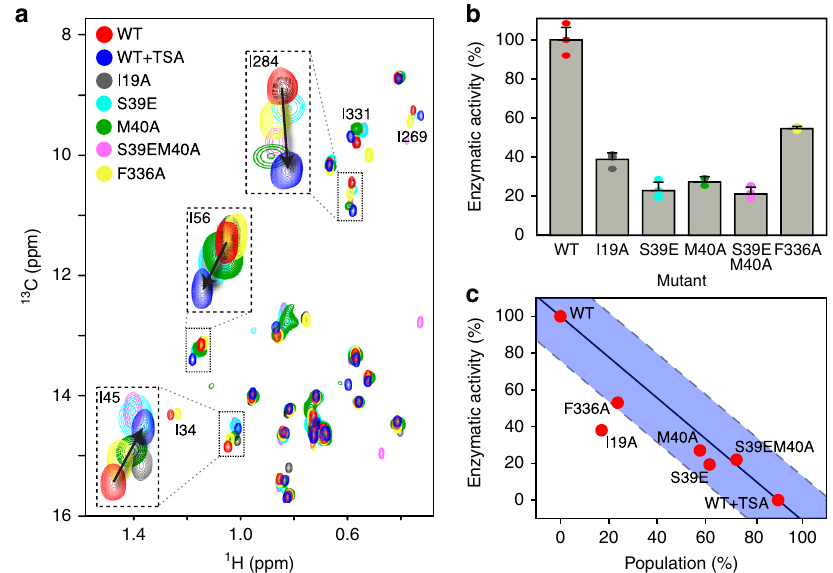
Fig. 3 The alternative state of the helix1-loop1-helix2 region is inactivating. a Overlay of methyl-TROSY NMR spectra of WT-HDAC8 (red), WT-HDAC8 with 2.5eq TSA (blue), and the fi ve mutations I19A (brown), S39E (cyan), M40A (green), S39EM40A (magenta) and F336A (yellow). The mutants stabilise the alternate state to varying degrees. b Relative enzymatic deacetylase activity of the HDAC8 mutants (see Methods). Vertical lines represent the uncertainty (r.m.s.d.). c Relative enzymatic activity versus population of the TSA-bound-like state of HDAC8. The full-drawn line connects WT and WT + TSA, while the blue shaded area indicates the r.m.s.d.